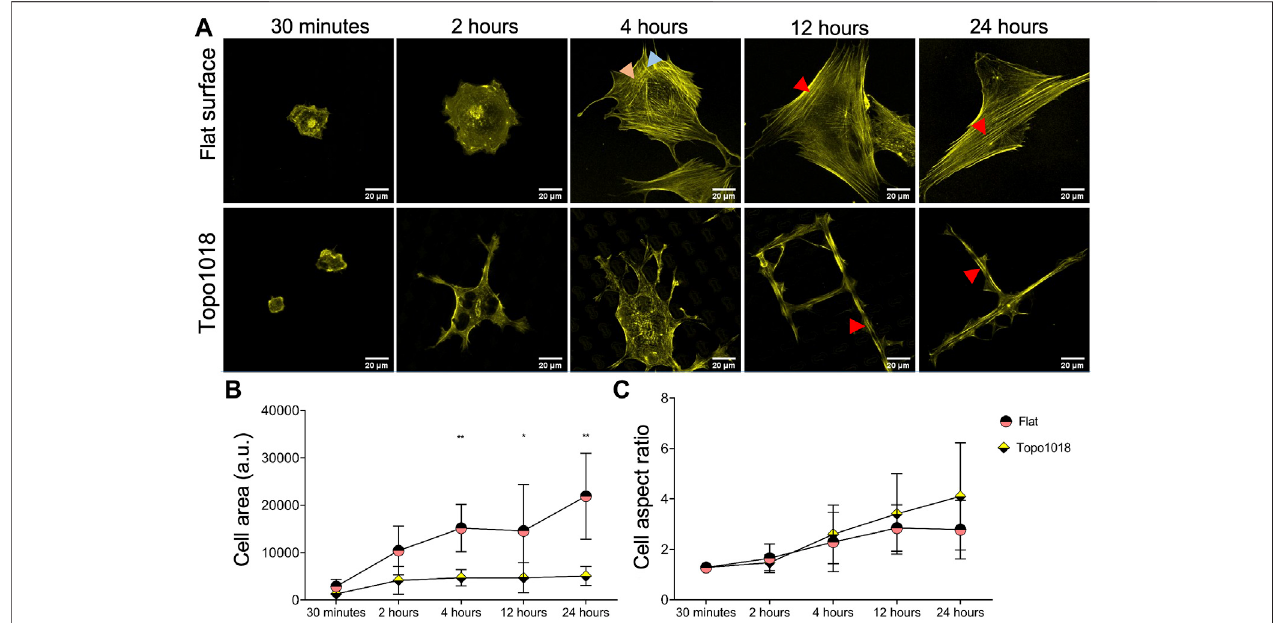
FIGURE 3 | hMSC shape and cytoskeletal organization on topography 1018 and fl at surfaces. (A) hMSCs cultured on a fl at surface and a Topo1018 surface and stained with phalloidin to visualize F-actin (yellow) at 30 min, 2, 4, 12, and 24 time points. On a fl at surface (top panel), transverse arcs and dorsal stress fi bers are observedat2 h.Thisreplacesitselfwiththickventralstress fi bersafter4 h.OntheTopo1018surface(bottompanel),hMSCsareontopofthepillarsandstress fi bersare observed on the lamellipodia on the bottom of the topography at 4 h. After 12 h, cells settled between the pillars and sat between the topographies and displayed longandthinkstress fi bersalongtheirlongaxis.Scalebars represent20 µM.Redarrowspointtheventralstress fi ber,bluearrowspointdorsalstress fi bers,andorange arrows pointthetransversearcs. (B) Quanti fi cation ofthecellareaover timeshowedthatafter 4 h,thedifferencebetweenthecellareabetweenhMSCsona fl at surface and a Topo1018 surface becomes signi fi cant. (C) Quanti fi cation of cell aspect ratio suggests that on the Topo1018 surface there is a steady increase in cell elongation while on a fl at surface it stabilized after 12 h (Error bars represent 95% con fi dence intervals, * p < 0.05, ** p < 0.01, and **** p < 0.001) (* ’ s correspond to comparisons between different culture substrates in the same time point). For all experiments, N =